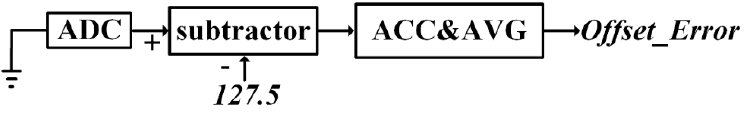
Figure 6. Offset error extraction diagram.